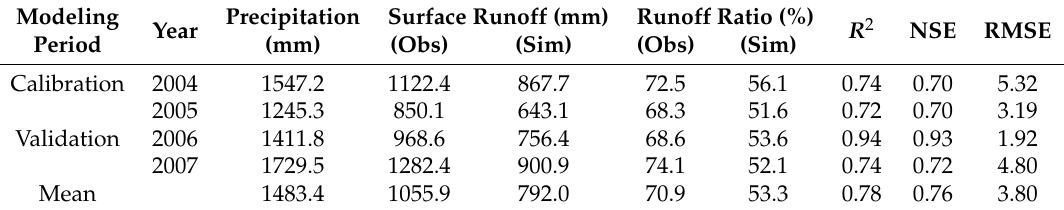
Figure 5. Time series for the surface runoff at Hapcheon dam site. Table 5. Performance of the rainfall-runoff model calibration and validation at the Hapcheon dam